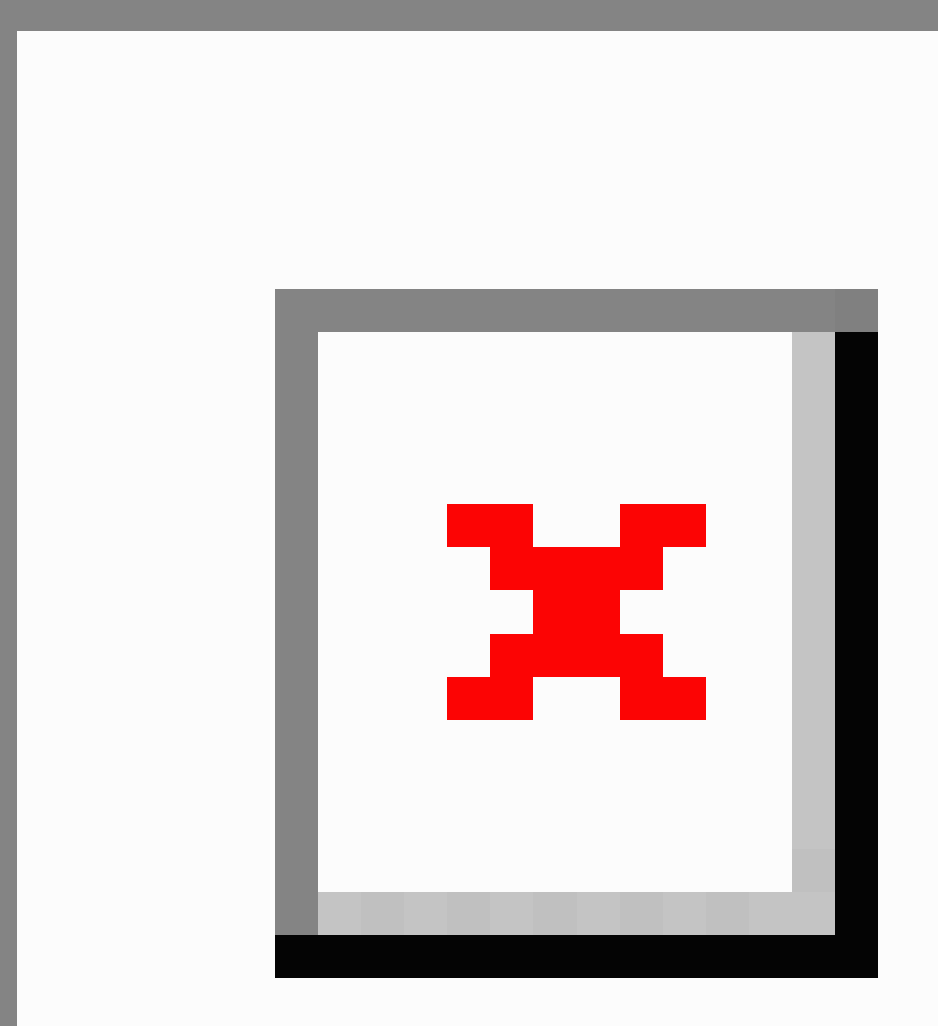
Figure 2. Detailed depiction of the operation principles of the SMARTFAMILY